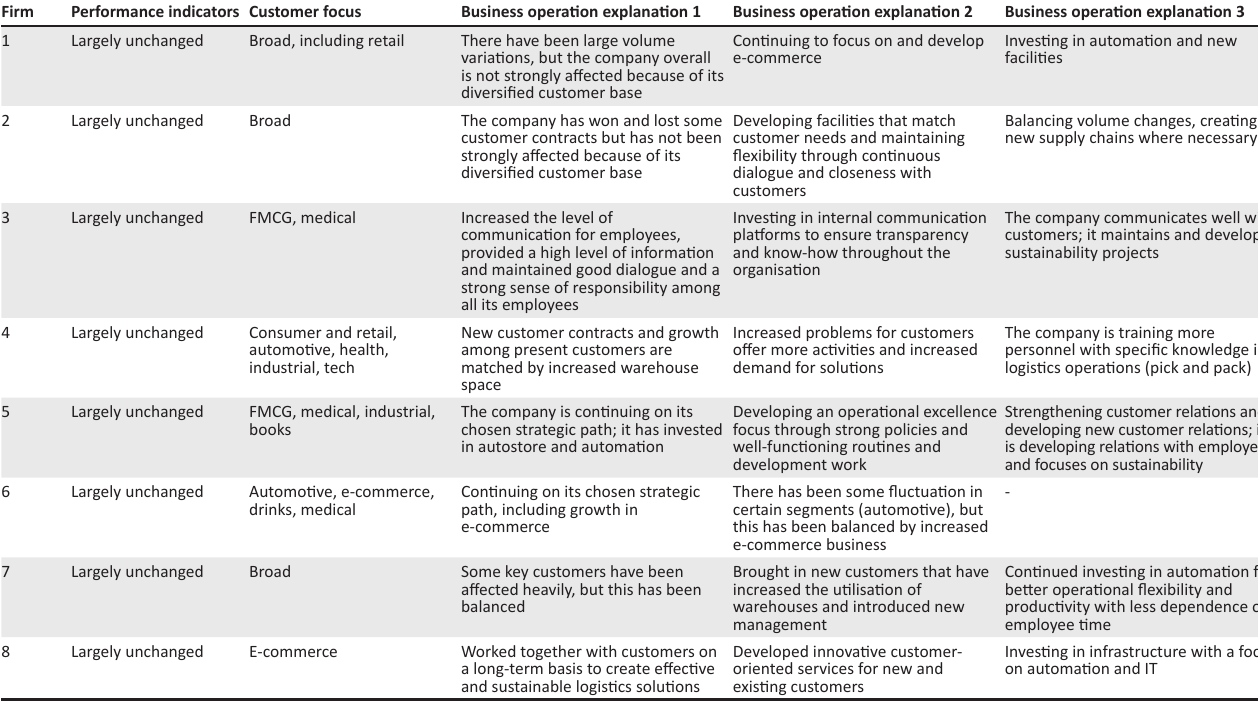
TABLE 3: Per-company findings: Large and successful.